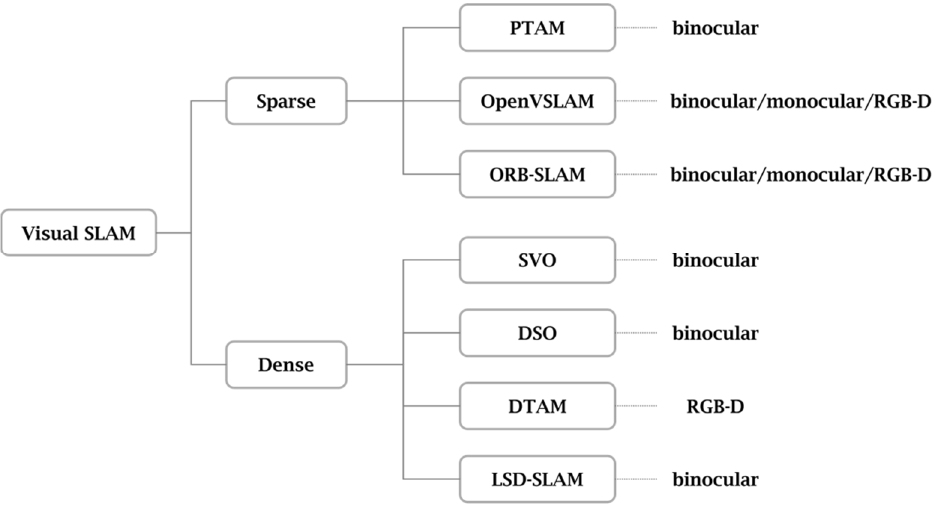
Figure 2. Classification of the Visual SLAM Technologies.